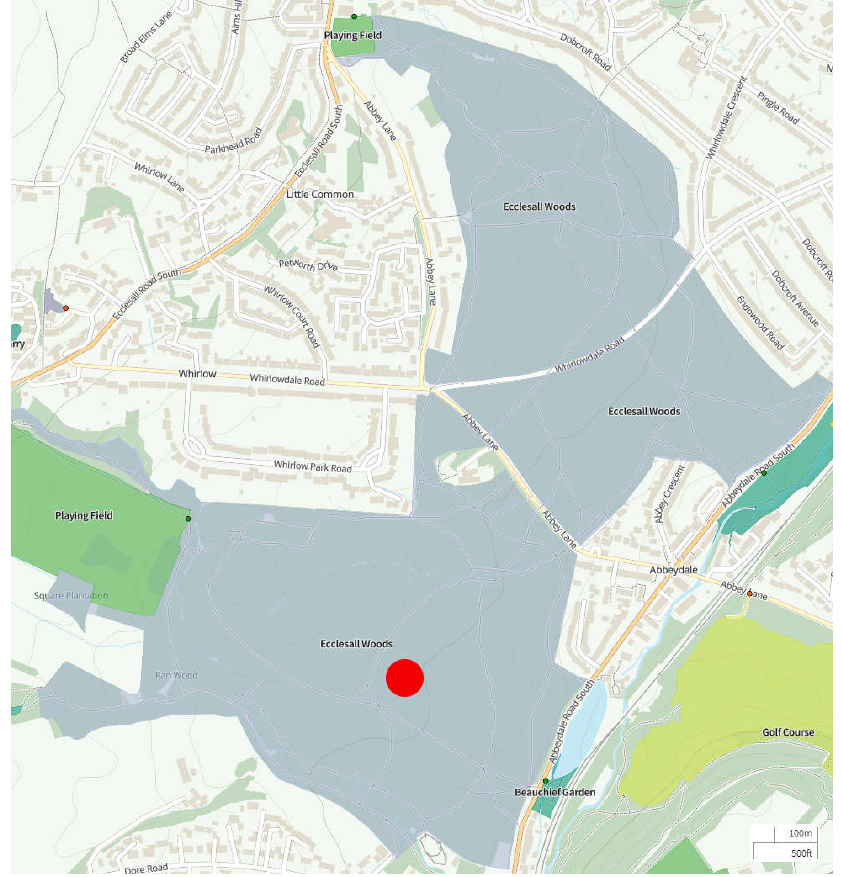
Figure 1. Map of sampling site in Ecclesall Woods. Red dot marks sampling site. Map courtesy of Ordnance